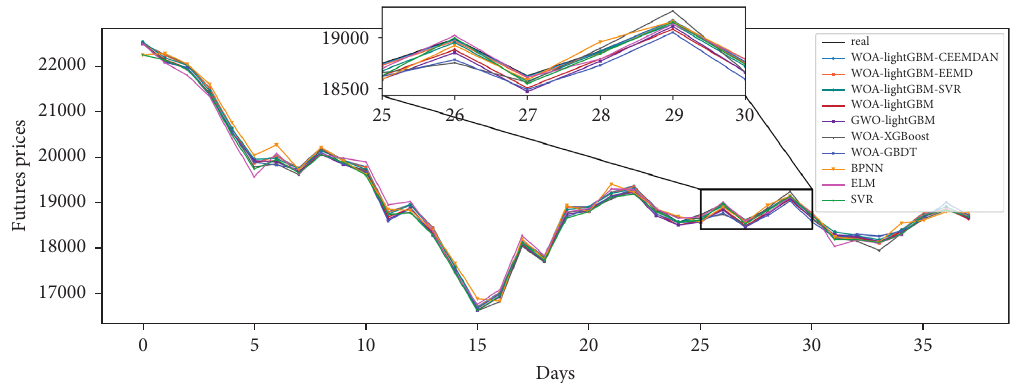
Figure 5: Predicted performance of the test set.